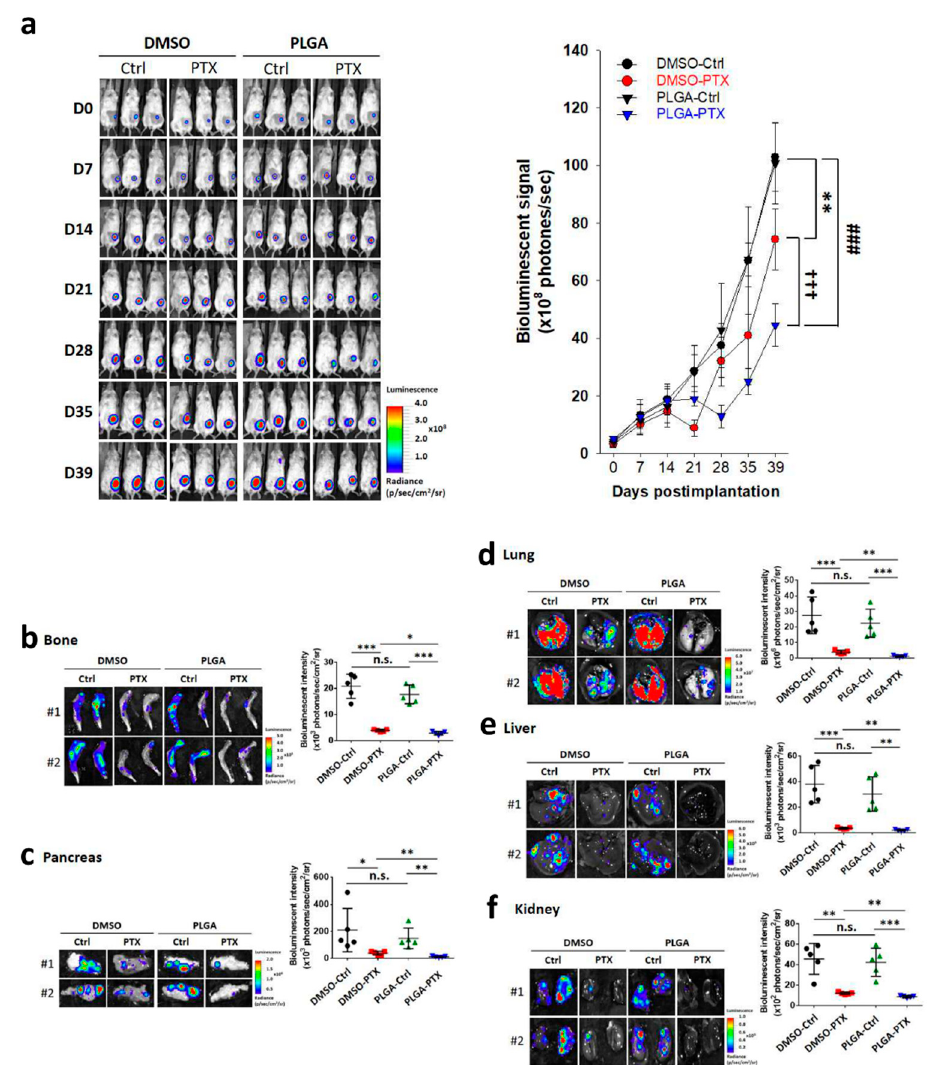
Figure 7. PTX-loaded PLGA nanofibrous membranes could enhance inhibition of tumor growth and metastasis in an orthotopic breast cancer model. ( a ) All mice were euthanized and dissected at 39 days, and representative noninvasive BLI examinations of tumor-bearing mice at indicated times were captured with the IVIS (left panel). Quantitative analysis using the Xenogen imaging signal intensity (photons/s) was performed at the indicated times. Data are expressed as mean ± SD. ** p < 0.01, ### p < 0.001, ††† p < 0.001. ( b – f ) Representative ex vivo BLI examinations of metastasis at the end of the MDA-MB-231-Luc orthotopic breast cancer spontaneous metastasis model. Bone ( b ), pancreas ( c ), lung ( d ), liver ( e ), and kidney ( f ) were isolated and imaged with bioluminescence at the end of the study; the mean signal for each group is indicated. Data are expressed as mean ± SD. * p < 0.05, ** p < 0.01, *** p < 0.001.